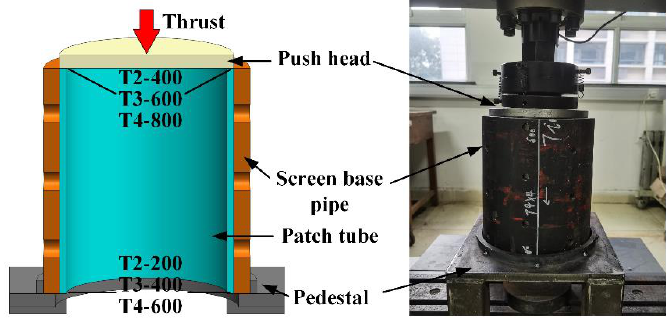
Figure 14. Hydroforming test results.